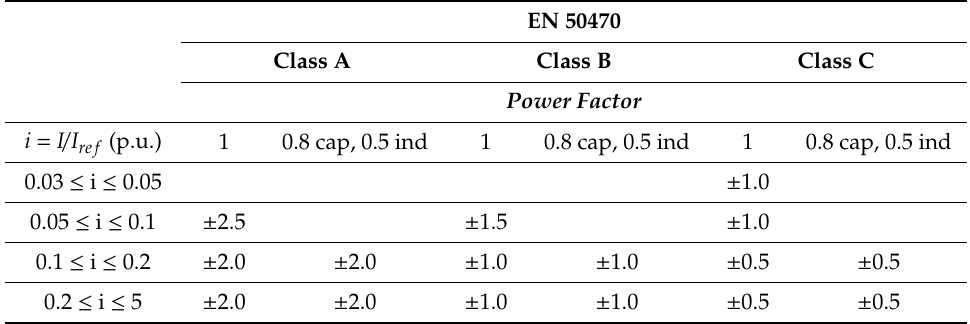
Table 1. Percentage error limits defined by EN 50470.